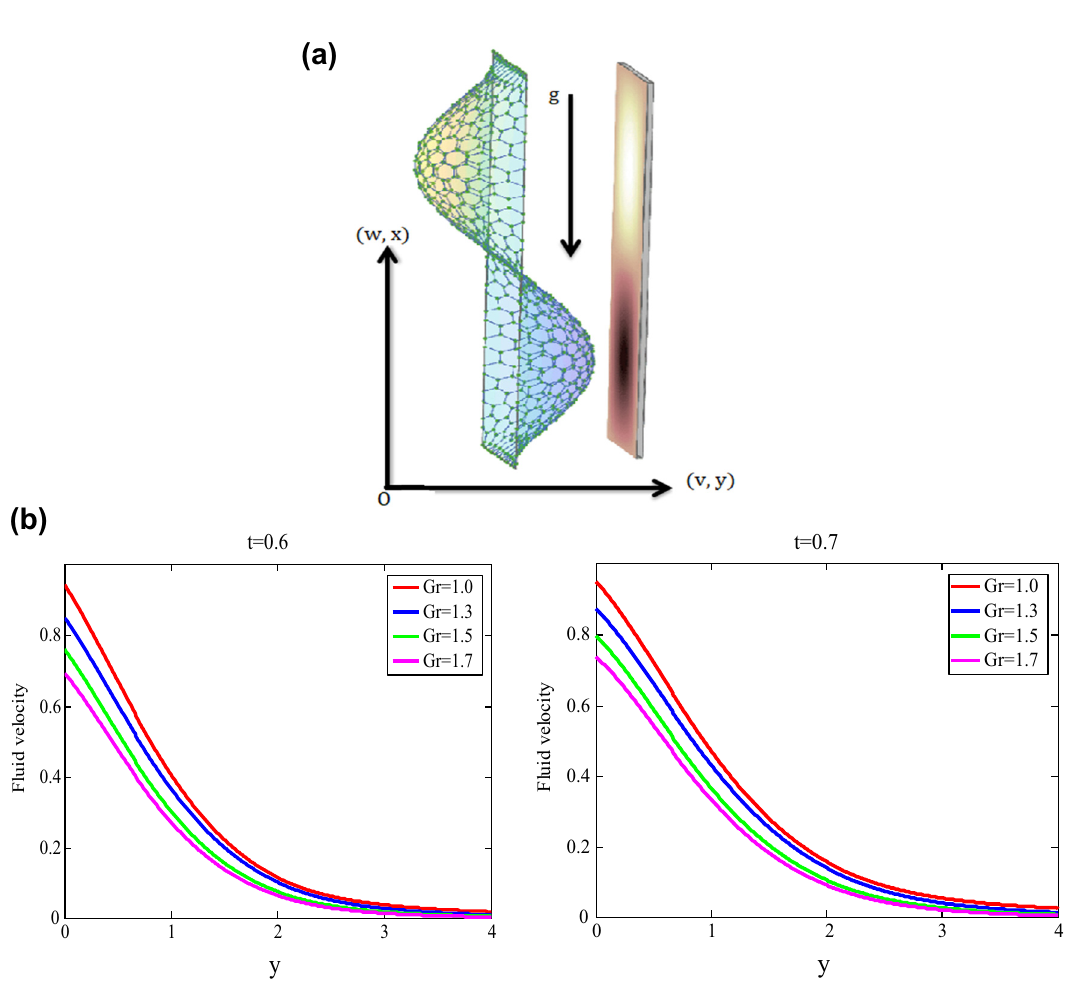
Figure 1: ( a ) Flow analysis of oscillating vertical plate. ( b ) The velocity for the variants of dimensionless factor Gr at di ff erent